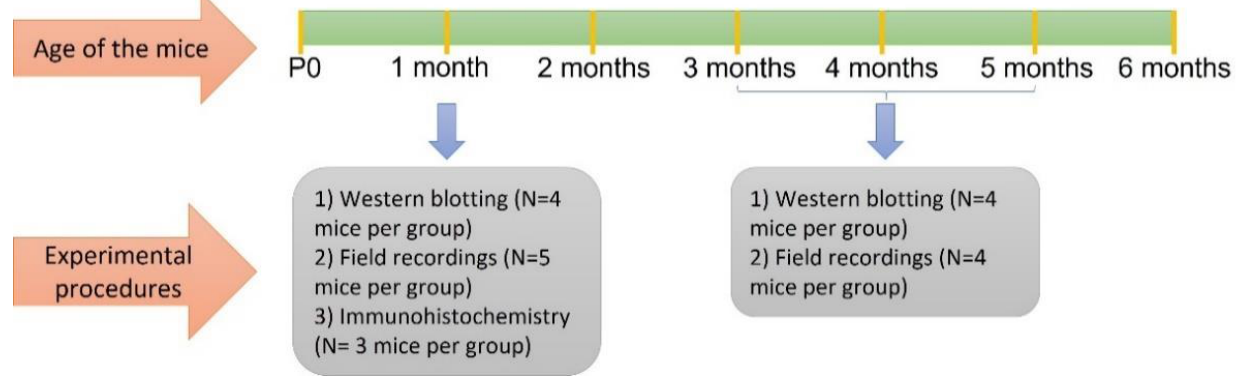
Figure 6. The timeline of experimental procedures together with the number of animals used for each experimental protocol.